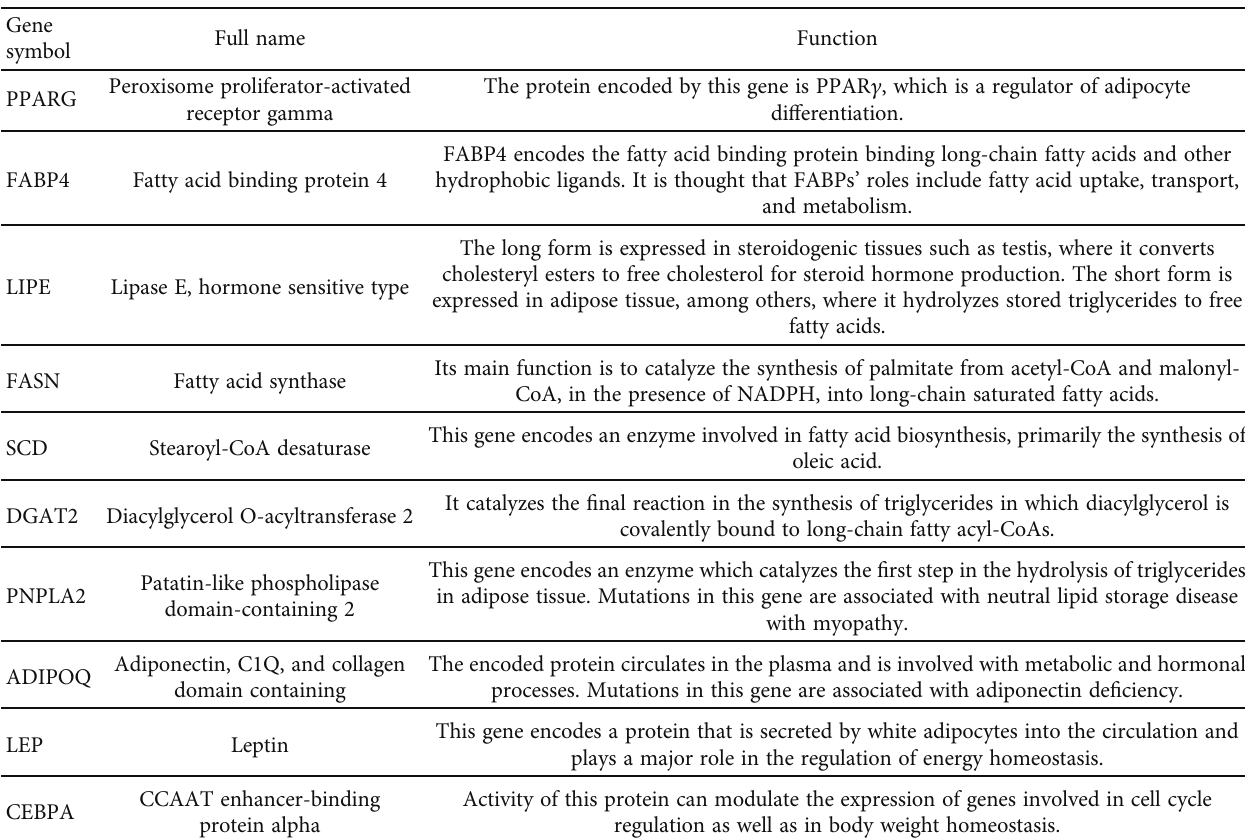
Table 1: Hub genes and their